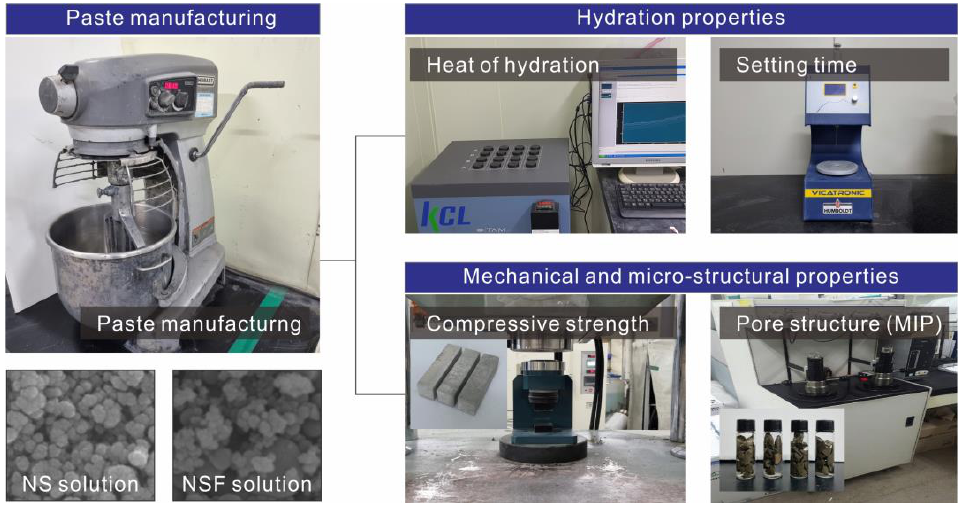
Figure 4. Schematic diagram of the test